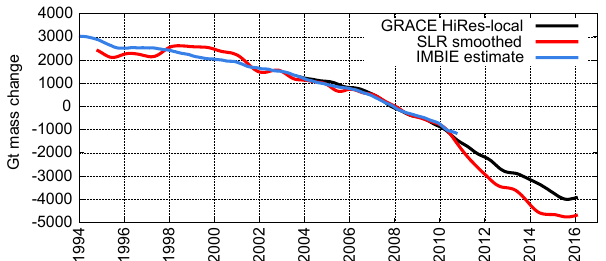
Figure 5. The high-resolution localized GRACE (black), Cheng 5 × 5 SLR (red), and IMBIE (blue) estimates of Greenland and Antarctica’s mass change. A 13-month smoother has been applied to the GRACE and SLR results, and they are scaled to include only the areas of Antarctica and Greenland, not the islands surrounding Greenland, to duplicate the IMBIE